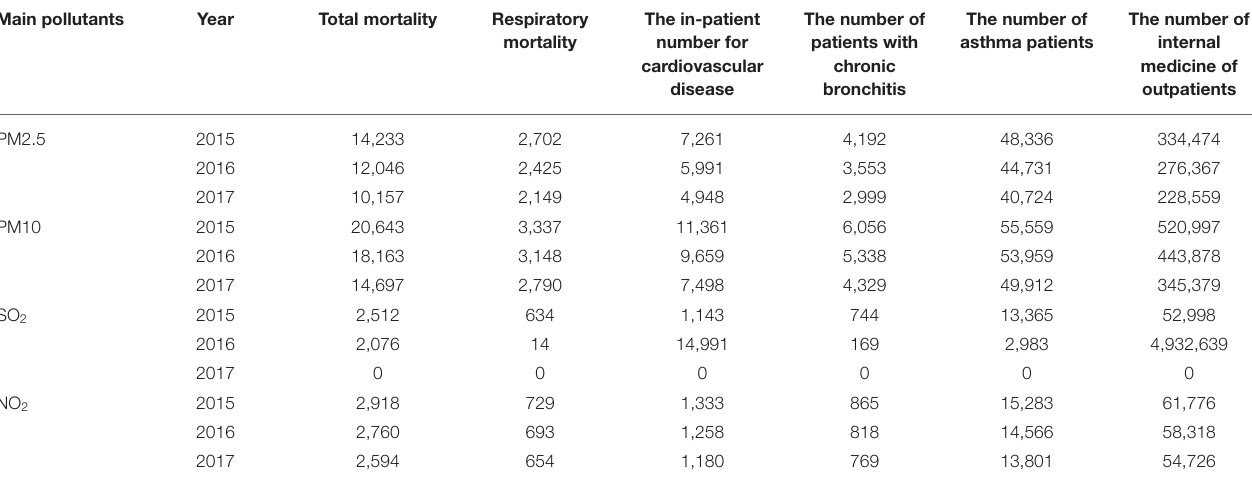
TABLE 6 | City health loss caused by pollutants in Z City (cases).